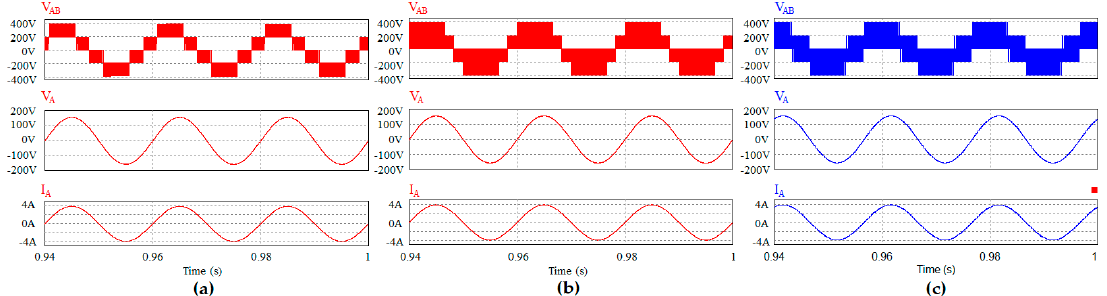
Figure 7. Simulation results of output line–line voltage ( V AB ), load voltage ( V A ), and output phase current ( I A ). ( a ) Method 1, ( b ) method 2, ( c ) proposed method.